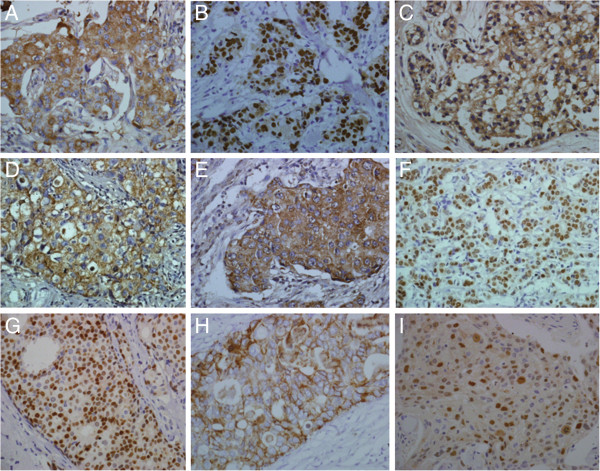
A (young group) BRCA1 protein immunohistochemical staining was positive. The positive products localized in the cytoplasm (× 400). B (young group) BRCA1 protein immunohistochemical staining was positive. The positive products localized in the nucleus (× 400). C (old group) BRCA1 protein immunohistochemical staining was positive. The positive products localized in the cytoplasm (× 400). D (young group) WWOX protein immunohistochemical staining was positive. The positive products localized in the cytoplasm (× 400). E (old group) WWOX protein immunohistochemical staining was positive. The positive products localized in the cytoplasm (× 400). F (young group) ER protein immunohistochemical staining was positive. The positive product positioning in the nucleus (× 400). G (young group) positive immunohistochemical staining of PR proteins. The positive products localized in the nucleus (× 400) H (young group) C-erbB2 protein immunohistochemical staining was positive. The positive products localized in the membrane (× 400). I (young group) Ki67 protein immunohistochemical staining was positive. The positive products localized in the nucleus (× 400).